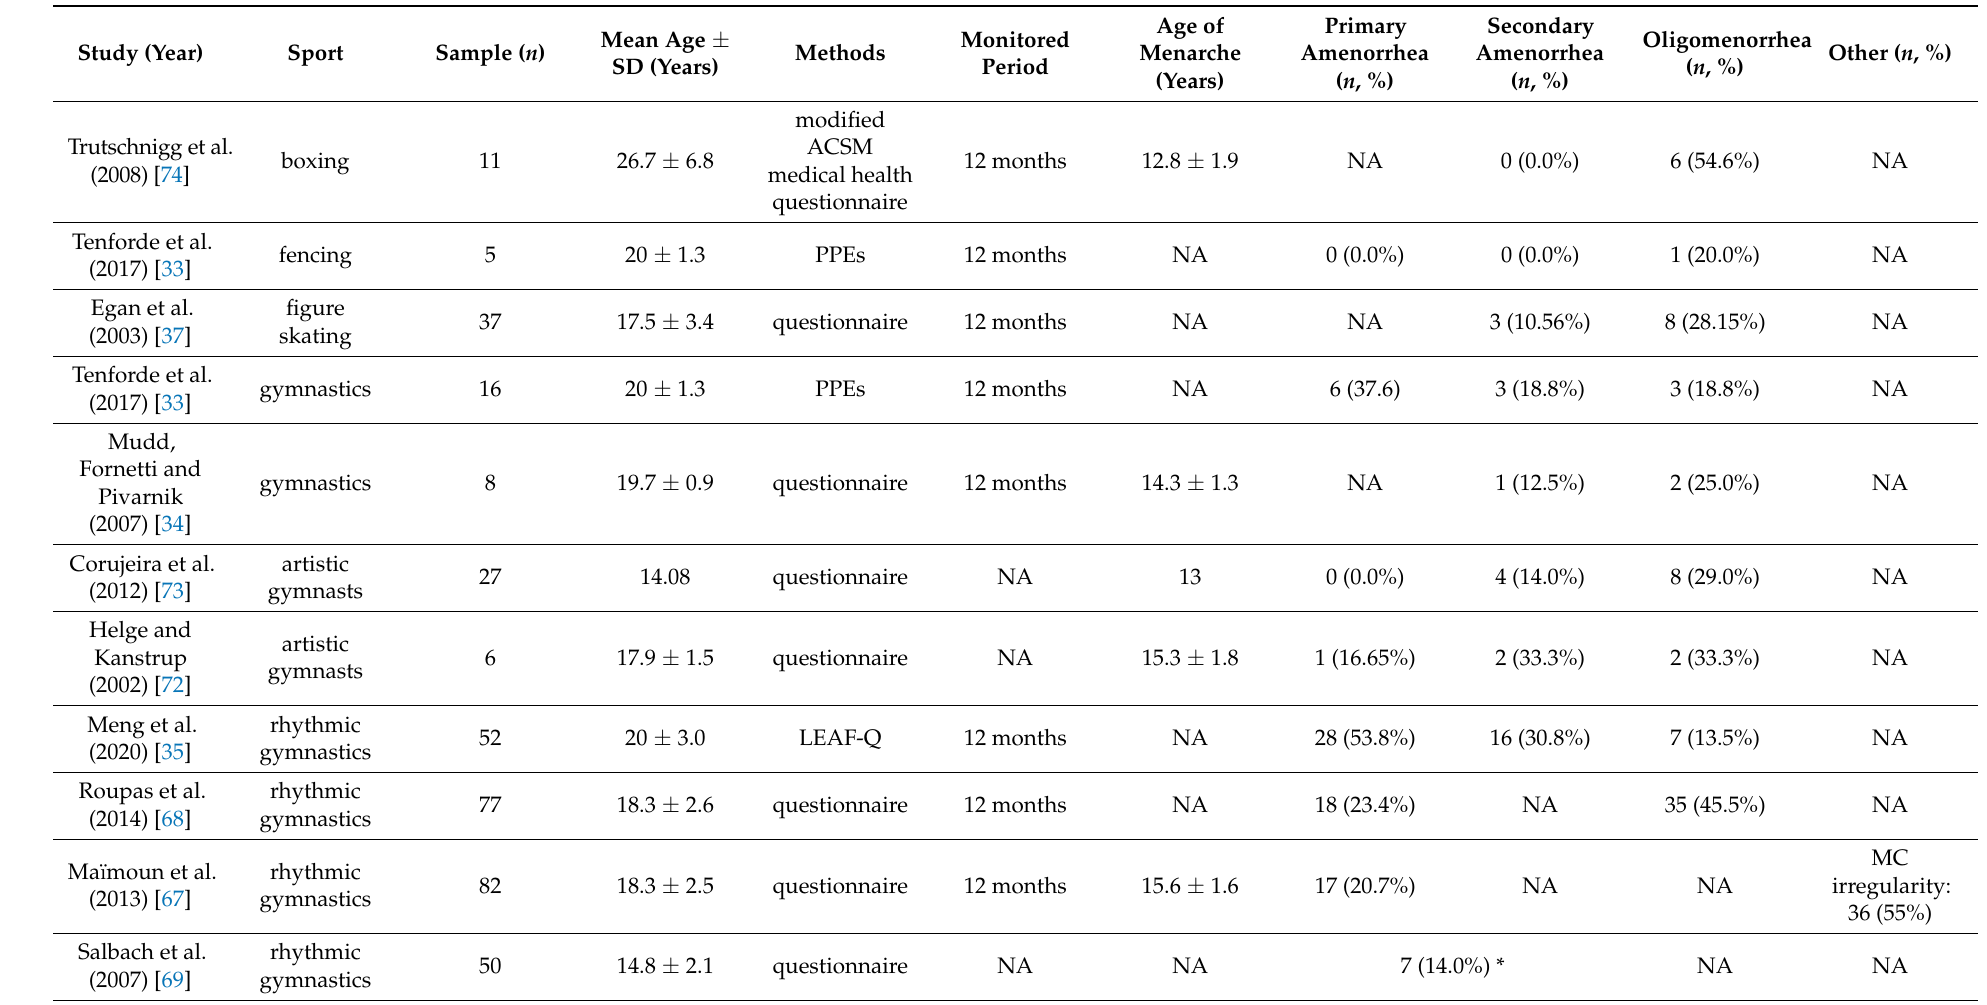
Table 4. Sample characteristics, menstrual disorders measurement and prevalence in other individual